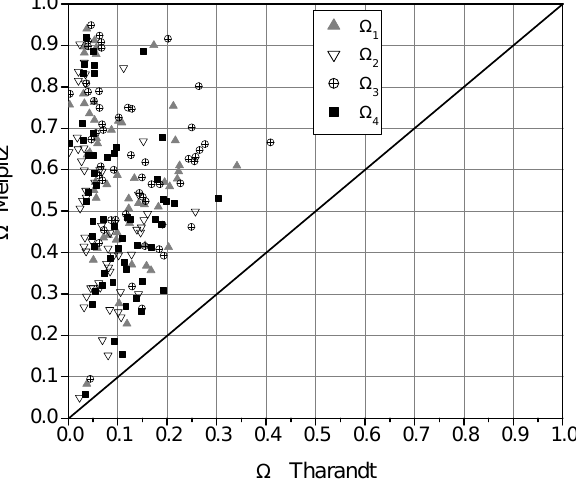
Fig. 8. Comparison of omega calculations according to Eqs. (1) to (4) and based on measurements at the Anchor Station Tharandt and at the Melpitz experimental site for the investigation period 18 to 21 June 2000 (half-hour means from 09:00 to 16:00LT).